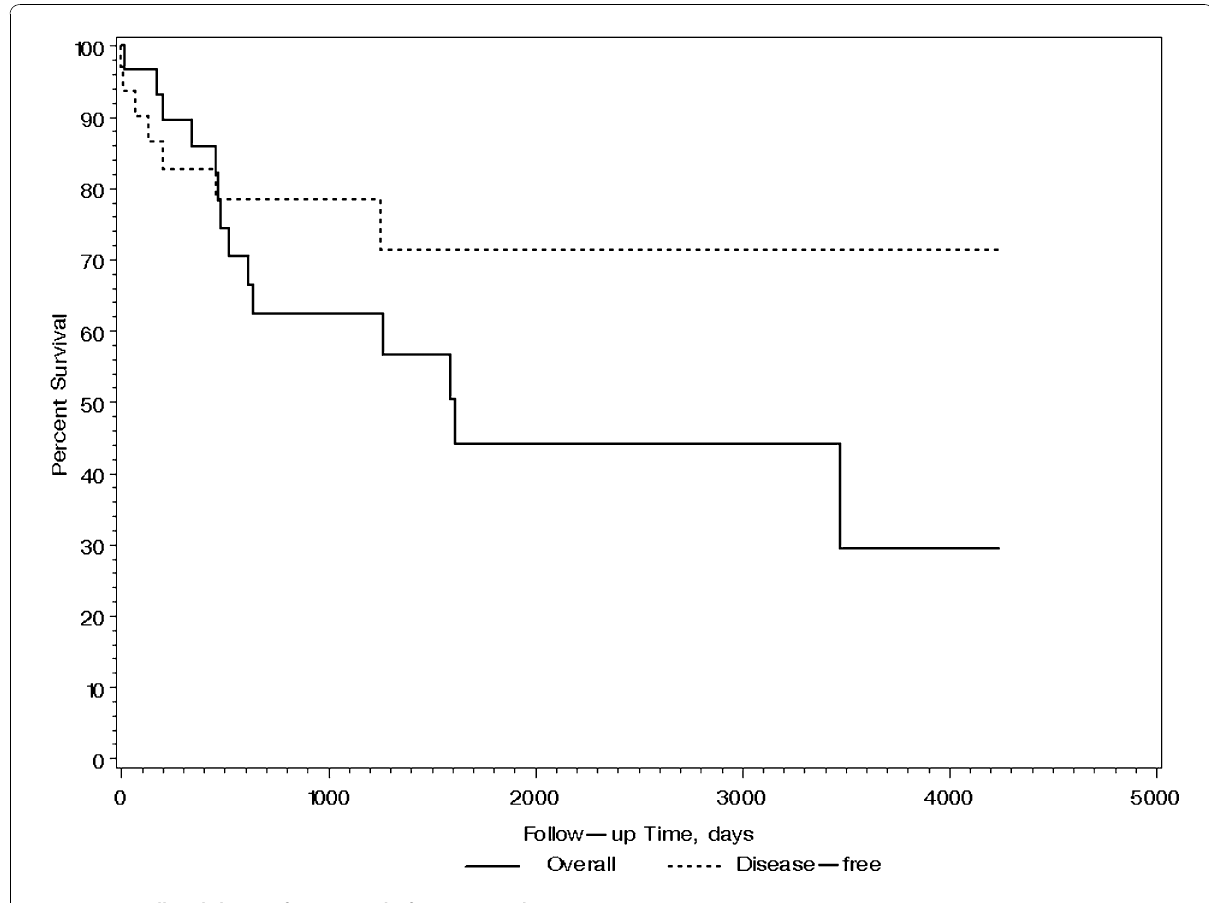
Figure 1 Overall and disease-free survival of patients with MBC